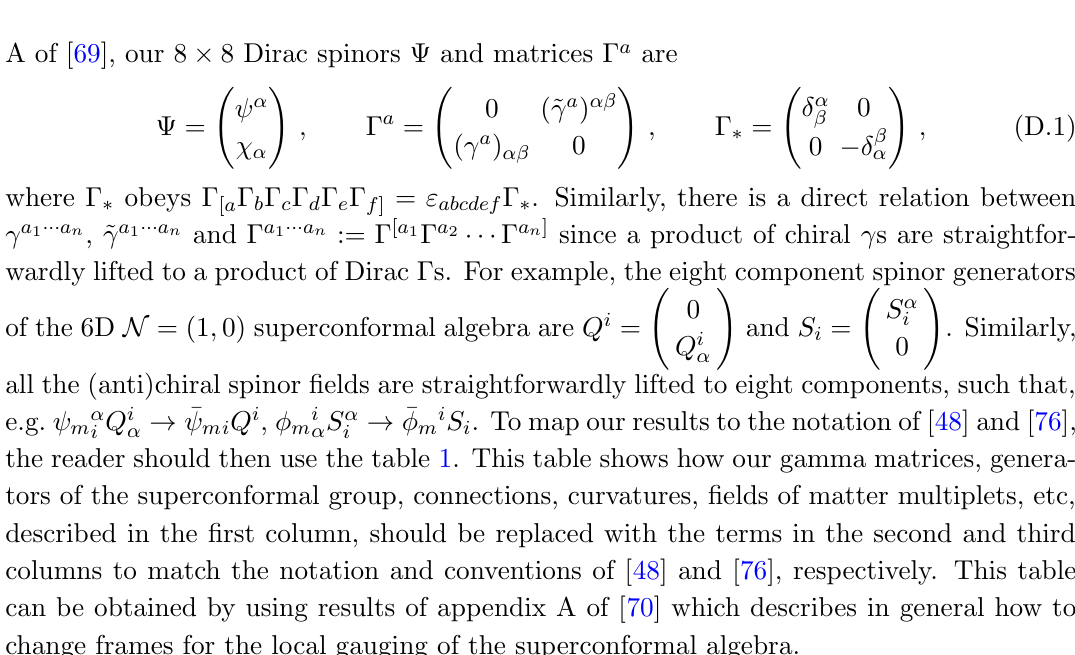
Table 1 . Di(cid:11)erent notation and